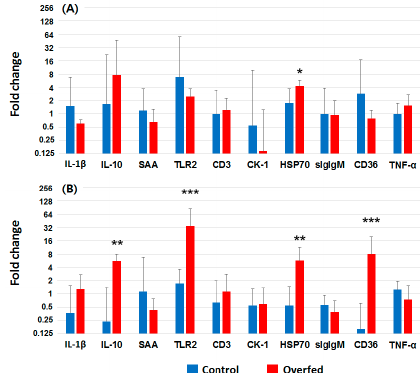
Figure 4. The relative interleukin-1 β (IL-1 β ), interleukin-10 (IL-10), serum amyloid A (SAA), toll-like receptor 2 (TLR2), cluster of differentiation 3 (CD3), chemokine-1 (CK-1), heat shock protein 70 (HSP70), secreted type of IgM (sIgM), cluster of differentiation 36 (CD36), and TNF- α expression in head kidney at ( A ) 2 weeks and ( B ) 8 weeks. The results are presented as the mean ± S.D. * p < 0.05; ** p < 0.01; and *** p < 0.001 indicate significant differences based on student’s t -test.